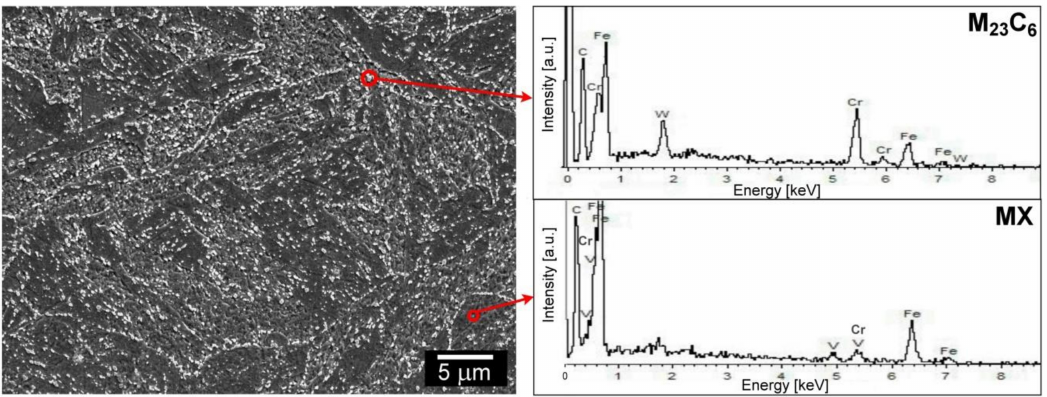
Figure 5. Scanning electron microscope (SEM)-micrograph of T92 steel region of the investigated T92/TP316H dissimilar weldment in “QT PWHT” condition and typical energy-dispersive X-ray